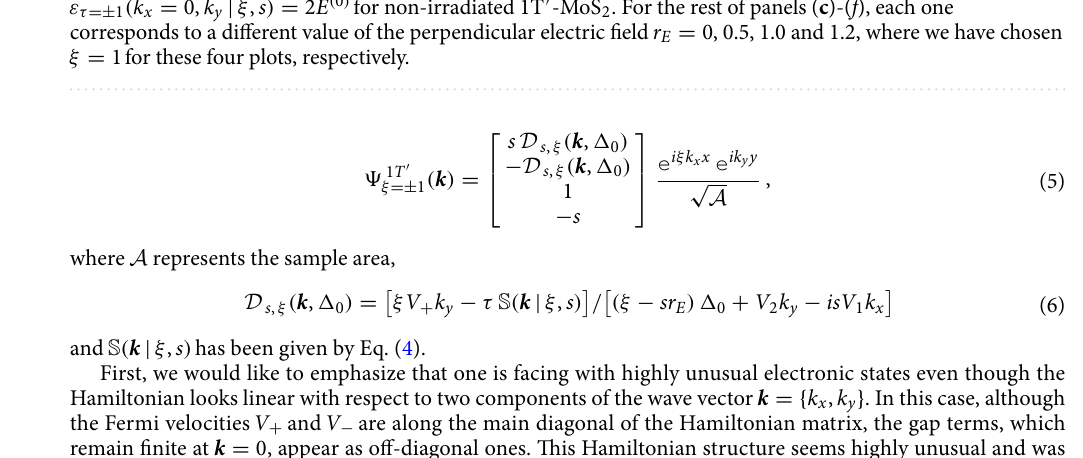
0.5 and 1.0 and a cut of = ′ -MoS 2 . For the rest of panels ( c )-( f ), each one 0 , 0.5, 1.0 and 1.2, where we have chosen =